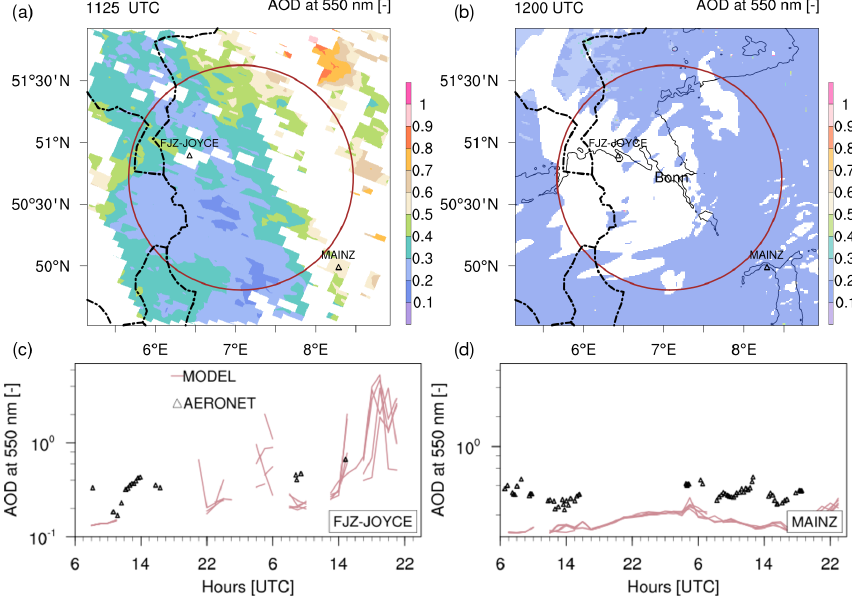
Figure 3. (a–b) Satellite and model estimates of aerosol optical depth (AOD at 550nm) over the Bonn radar domain on 4 July 2015. The two available AERONET stations over the Bonn radar domain are also shown. (c–d) Time series of measured and simulated ensemble AOD over FJZ-JOYCE and MAINZ AERONET